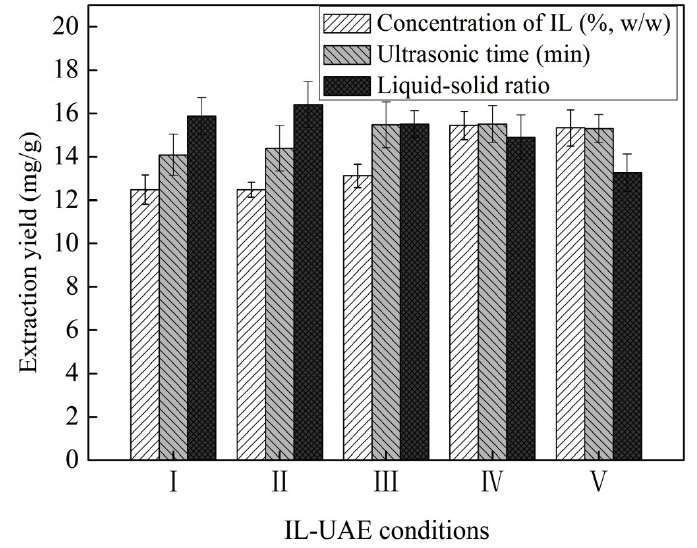
Figure 2. Single-factor experiments of IL concentration (I–V represent the IL concentrations of 20%, 30%, 40%, 50%, and 60% ( w / w )),ultrasonic irradiation time (I–V represent the ultrasonic irradiation time of 20, 30, 40, 50, and 60 min), and liquid–solid ratio (I–V represent the liquid–solid ratio of 10:1, 20:1, 30:1, 40:1, and 50:1) for the extraction of SDG using